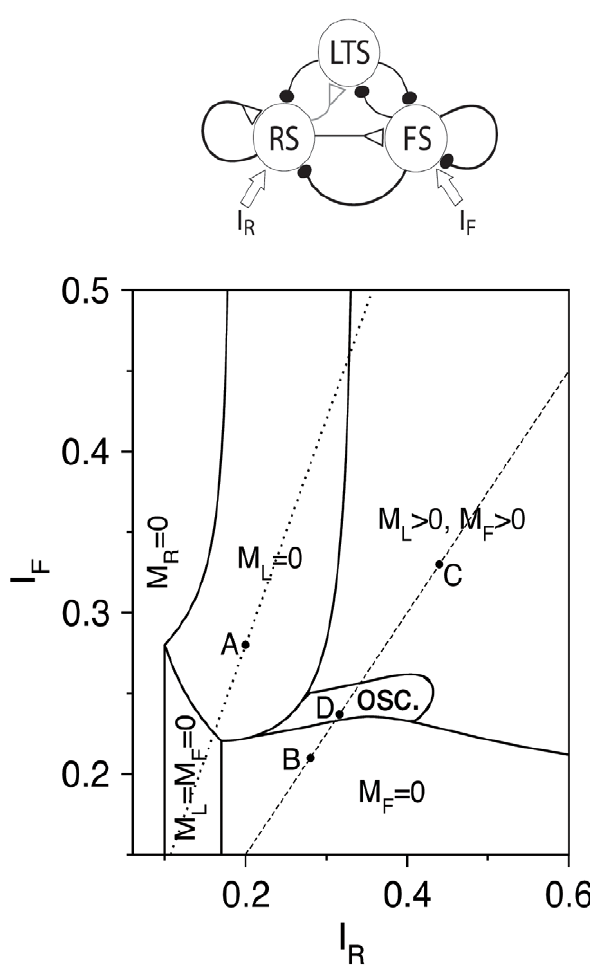
Figure 9. Phase diagram of the steady-state behavior of an RS- LTS-FS network (Table 2) in the I R 2 I F plane. Regimes are defined according to the network state at large times. The network reaches a rest state with constant M R , M L , and M F in all the regimes except of the oscillatory regime, denoted by ‘‘osc.’’. In the regime denoted by ‘‘ M R =0’’, RS cells are quiescent; they are active in all other regimes. Those regimes are defined according to the activity of LTS and FS neurons. FS neurons are active and LTS neurons are quiescent in the regime denoted by ‘‘ M L =0’’, LTS neurons are active and FS neurons are quiescent in the regime denoted by ‘‘ M F =0’’, and both neuronal populations are active in the regime denoted by ‘‘ M L . 0, M F . 0’’. The dotted and dashed lines denote the ratios I F =1.4 I R and I F =0.75 I R respectively, for which calculations shown in Figure 10 are made. The solid circles labeled ‘‘A’’–‘‘D’’ denote values of I F and I R for Figure 11A–D.